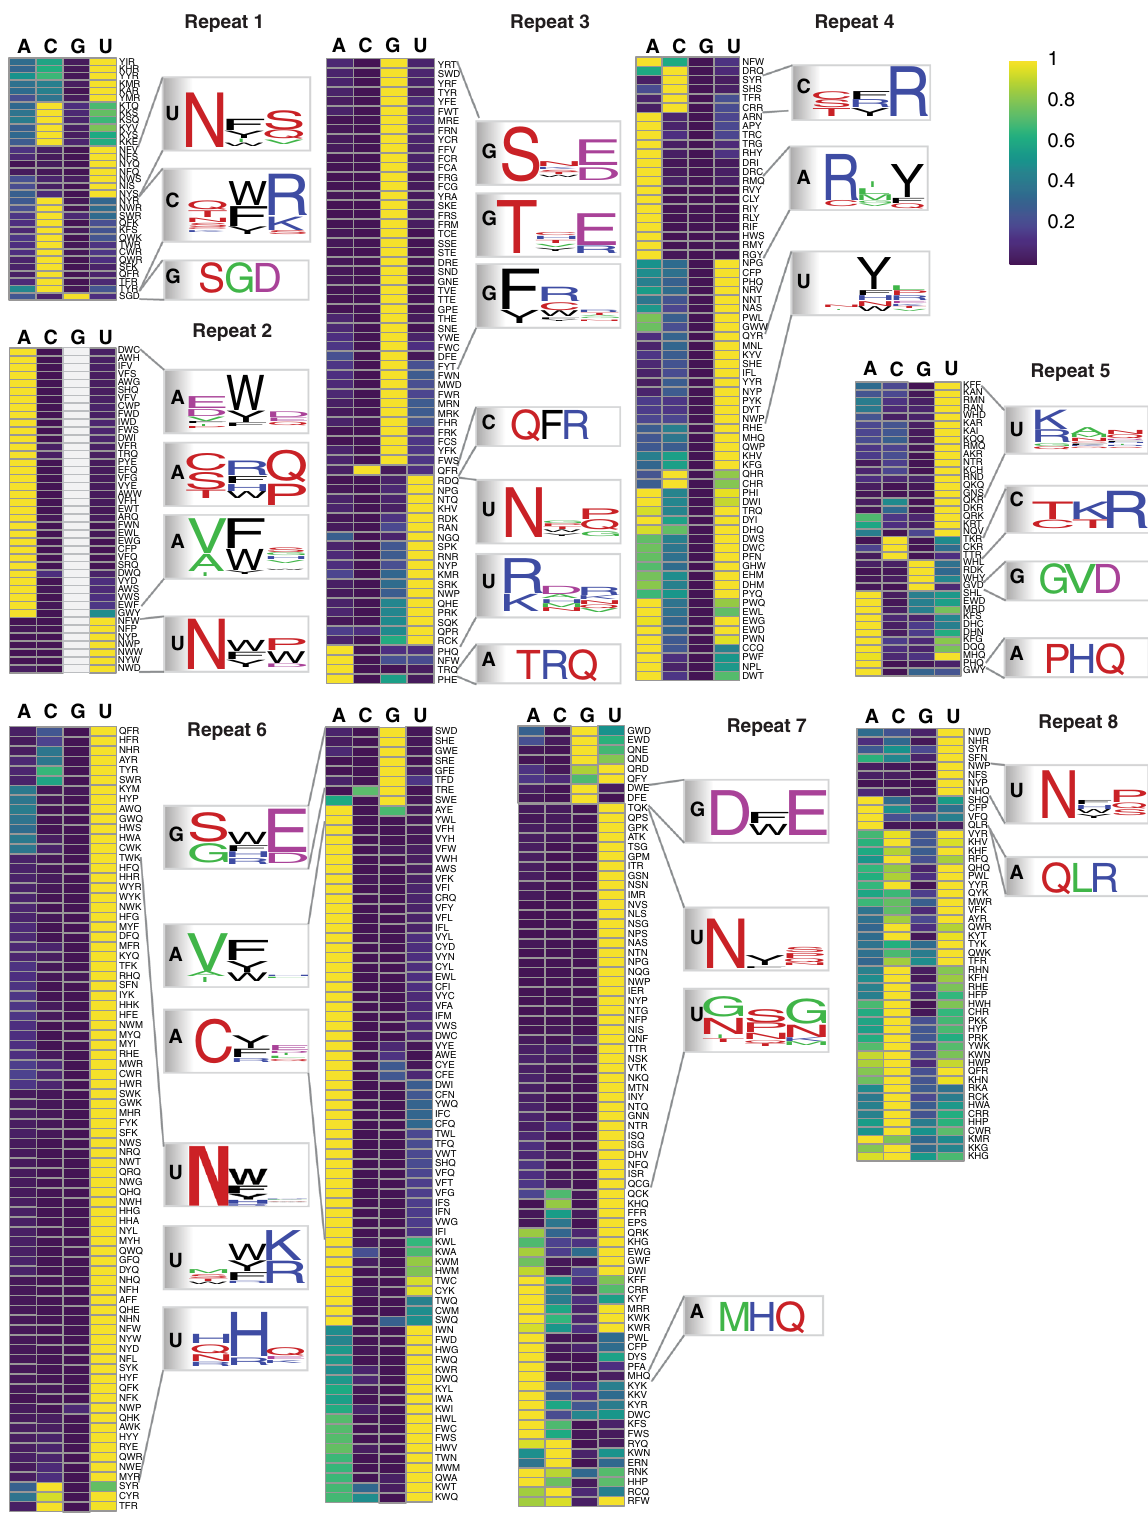
Fig. 3 Heatmaps showing unsupervised clustering of PUF variants with interaction score >5 for repeats 1 – 8. The color intensity represents the relative interaction score normalized by the maximal value for each row. Yellow indicates a high interaction score and blue indicates a low interaction score. Sequence logos summarizing the base-speci fi c recognition patterns are shown nearby the heatmap for each